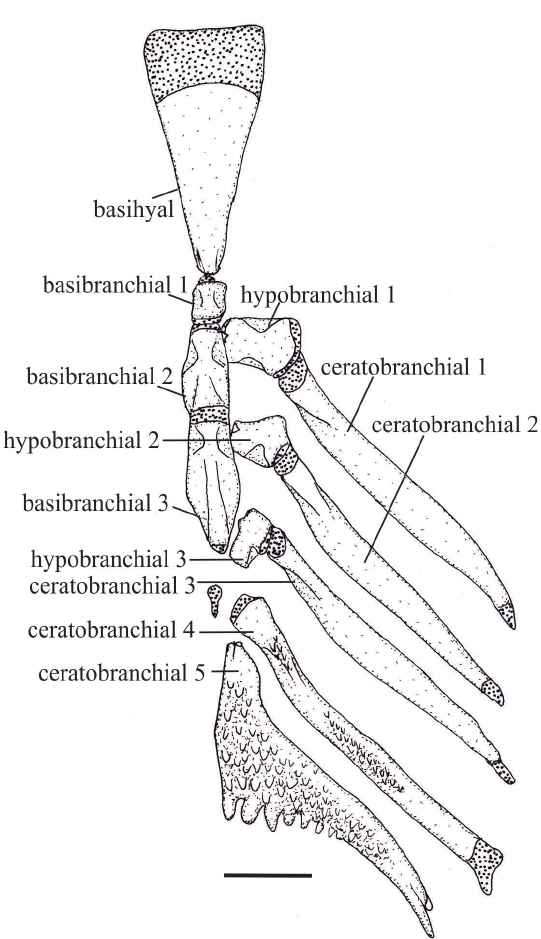
Figure 11. Basihyal and ventral branchial arches, right and median portion, dorsal view, of Melanorivulus flavipinnis , paratype, UFRJ 6883, 25.6 mm SL. Larger stippling indicates cartilage. Scale bar: 0.5